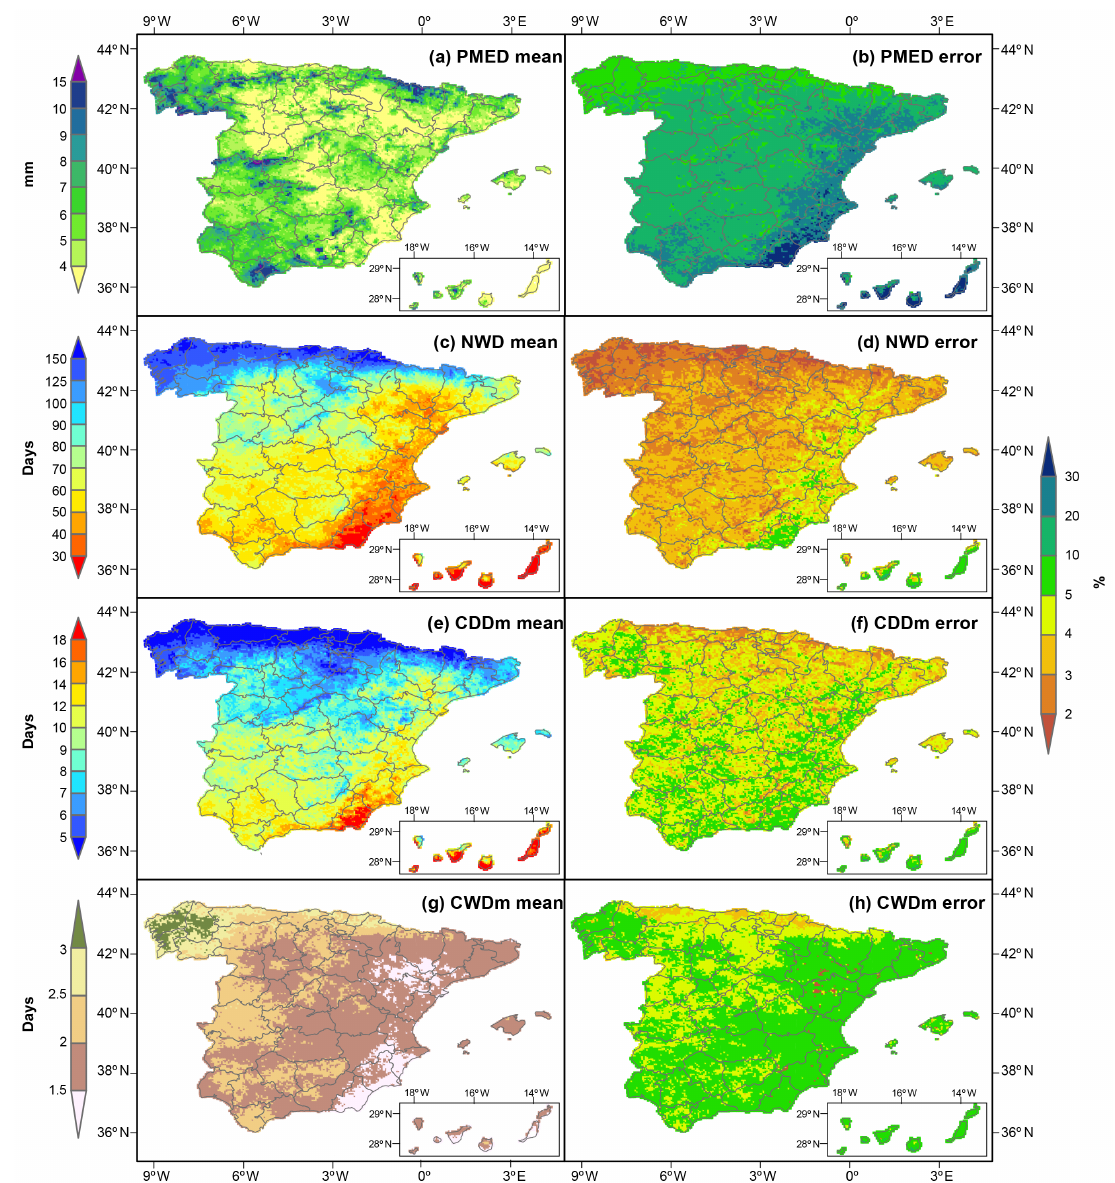
Figure 5. Daily precipitation indices (a, d, e, g) and their uncertainty (b, d, f, h) . PMED: daily mean precipitation intensity; NWD: number of wet days; CDDm: mean consecutive dry days; CWDm: mean consecutive wet